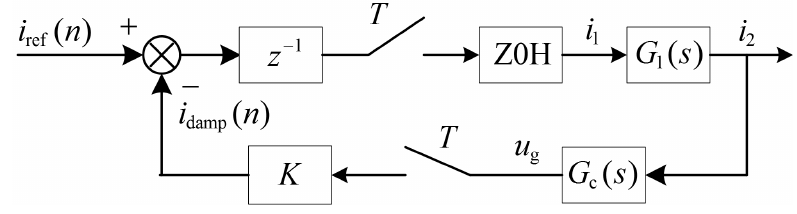
Figure 3. Frequency response characteristics: ( a ) magnitude; ( b ) phase.